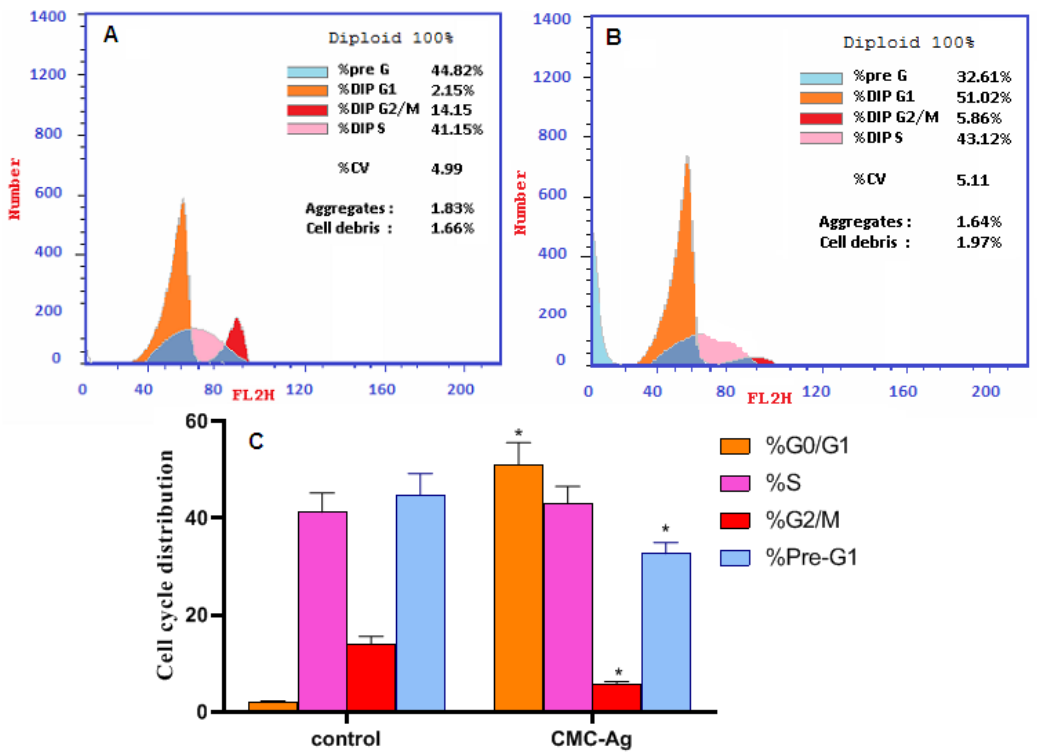
Figure 7. Flow cytometry analysis of the cell-cycle distribution of HepG2 cells. ( A ) Control, ( B ) CMC-AgNPs, and ( C ) a graphical represent of cell-cycle distribution analysis among different treated cells. * Significantly different from the control group at p < 0.0001.